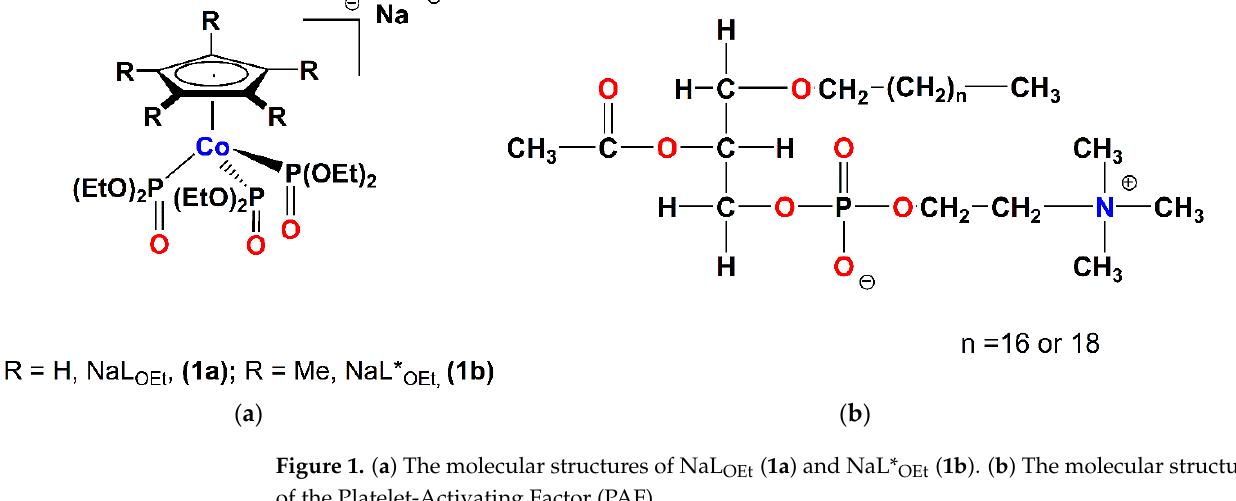
Figure 1. ( a ) The molecular structures of NaL OEt ( 1a ) and NaL* OEt ( 1b ). ( b ) The molecular structure of the Platelet-Activating Factor (PAF).